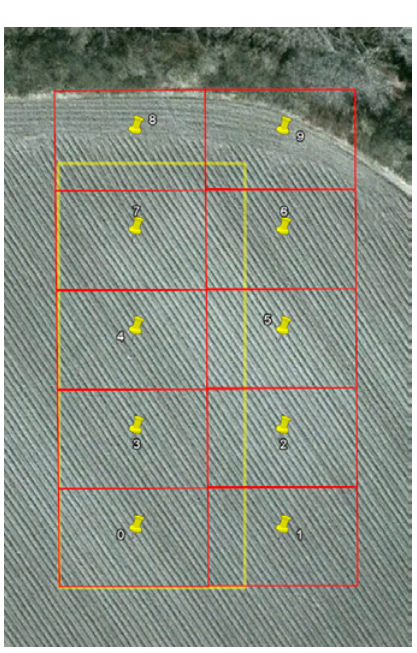
Figure 4: The area (yellow) and the resulting waypoints (yellow pins) with the calculated field of view of the camera (red, overlap is not displayed) in GoogleEarth c